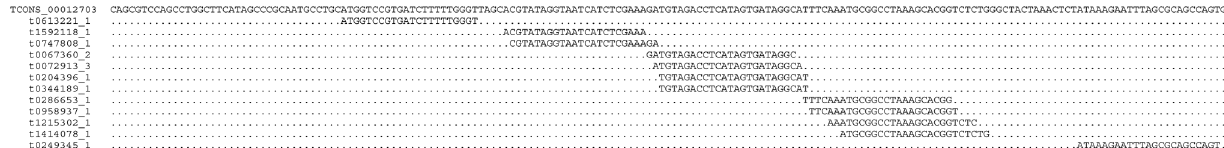
Figure 3. The TCONS_00012703 were mapped with multiple siRNA reads.